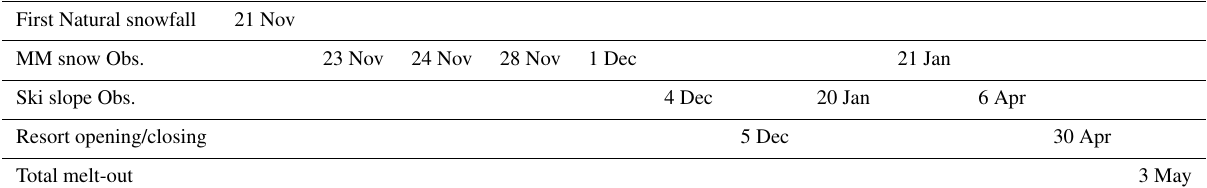
Table 1. Dates of the field campaign carried out during the 2015–2016 winter season. “MM snow Obs.” and “Ski slope Obs.” correspond respectively to dates when observations were performed on MM snow piles and ski slope. First Natural snowfall MM snow Obs. Ski slope